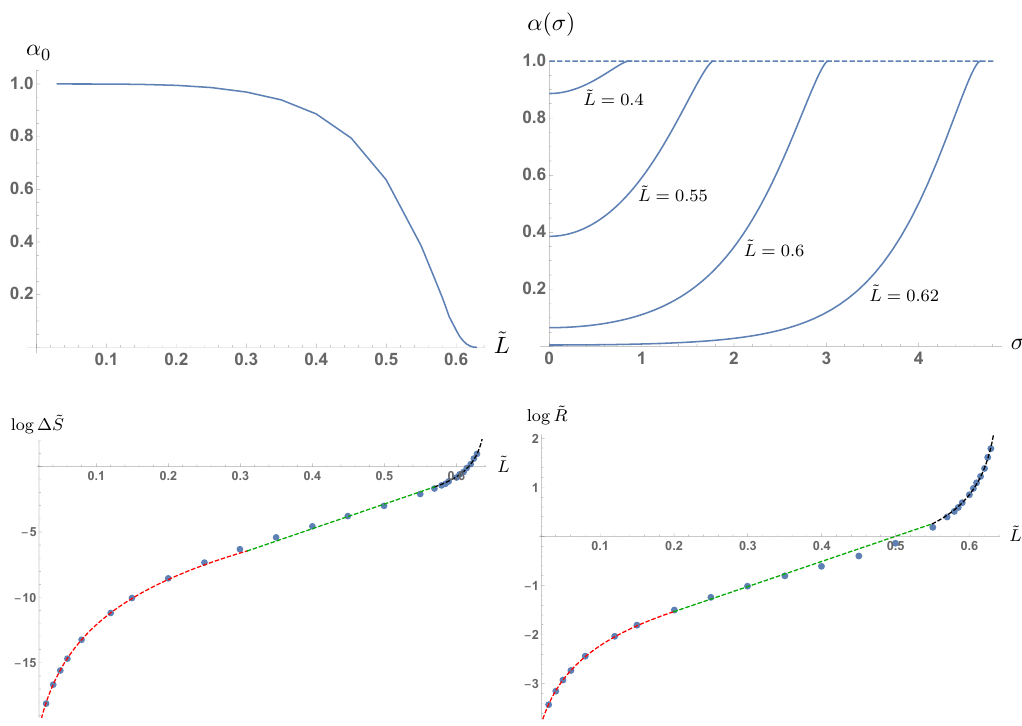
Figure 9 . On the top left, we depict the values of α 0 in the variational approximation to the bounce solution as a function of ˜ L . Notice that α 0 → 0 for ˜ L → 0 . 6442 and the interior of the bubble is very close to the true vacuum. On the other hand α 0 → 1 as ˜ L → 0 . On the top right, we depict the numerically found profiles for four values of ˜ L . On the bottom, we depict the on-shell action and the radius of the O(3) -bubble as a function of ˜ L in a semilogarithmic scale. The dots represent numerically computed data and the dashed lines correspond to the analytic approximation given in eqs. (5.33) and (5.34). Different colors correspond to different expressions of the piecewise